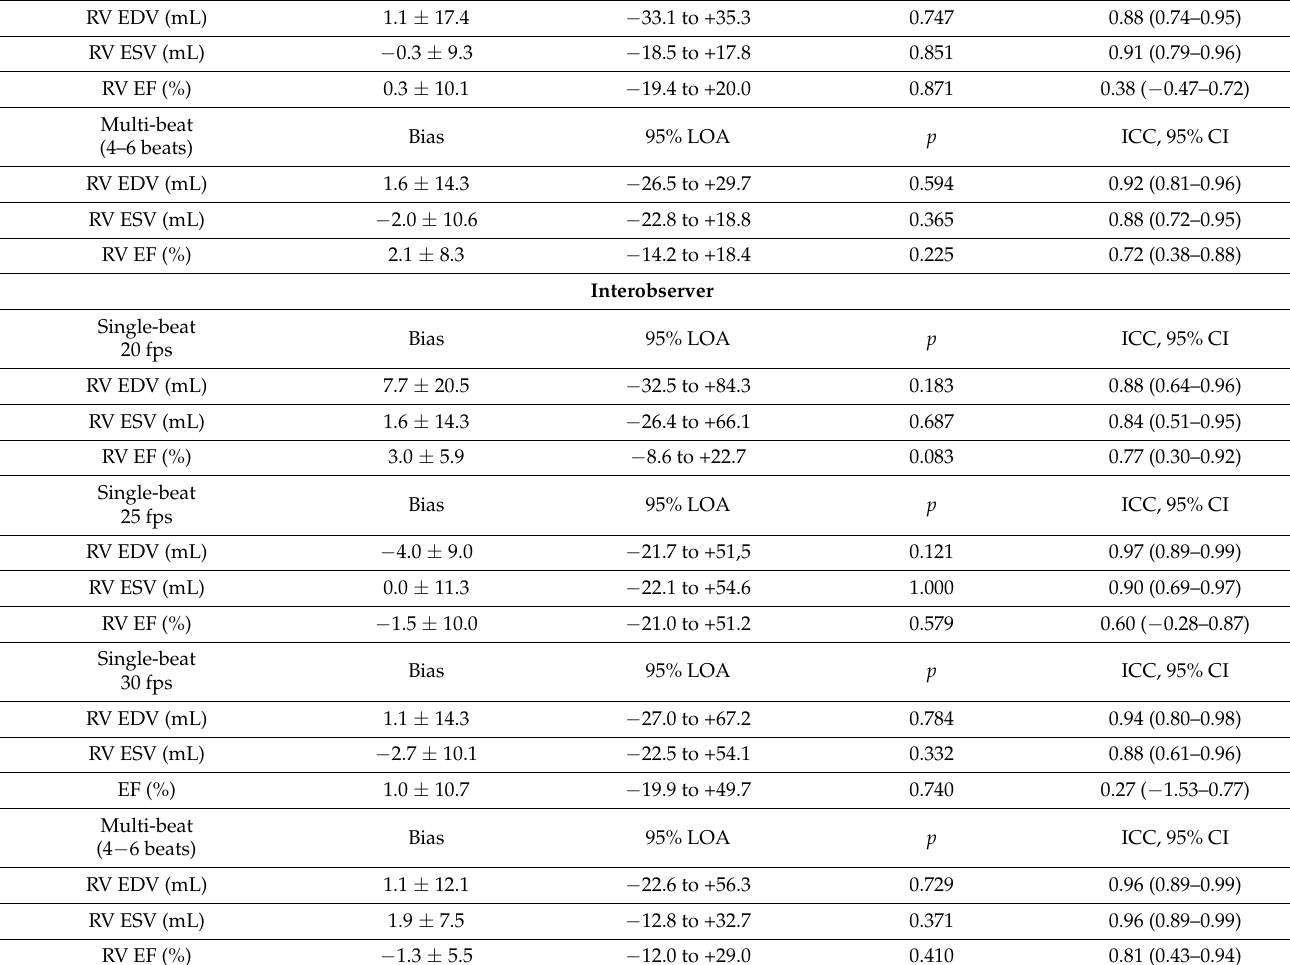
Table A3. Comparison of different settings in 3DE single-beat acquisition with multi-beat